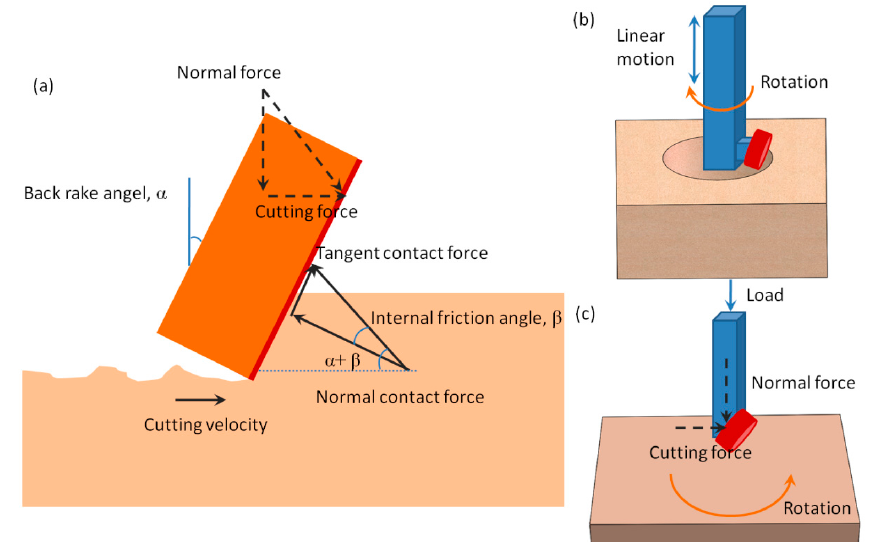
Figure 3. Schematic illustration of ( a ) single cutter force in cutting rock, ( b ) cutter–rock interaction in developed testing apparatus, and ( c ) cutter–rock interaction in